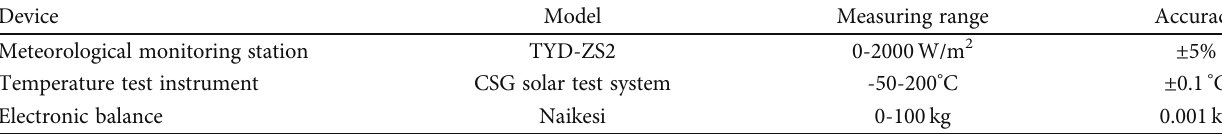
Table 2: Parameters of the experimental test